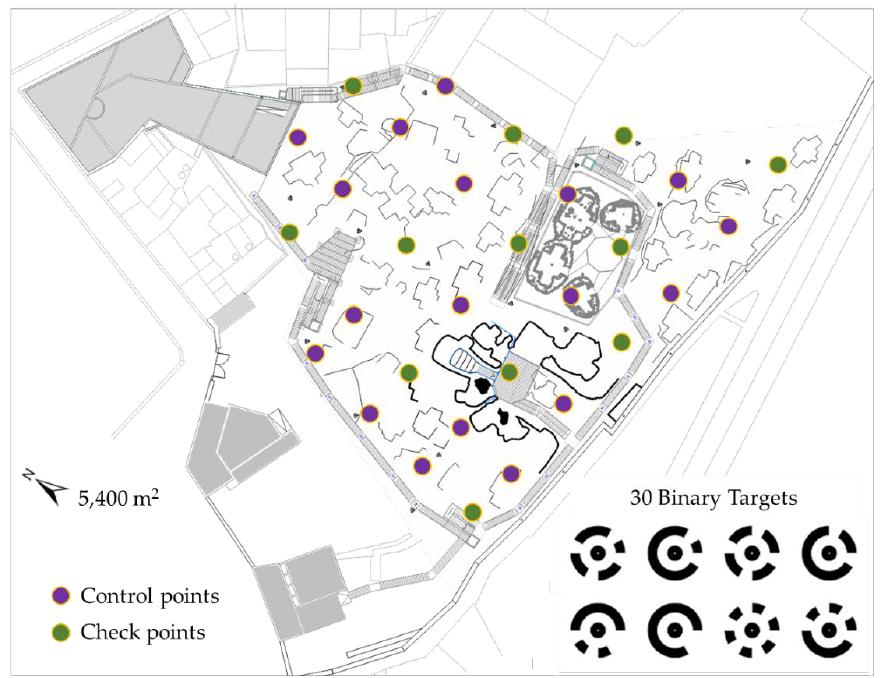
Figure 4. Photogrammetric network designed based on the 12-bit binary targets of 10 cm diameter.